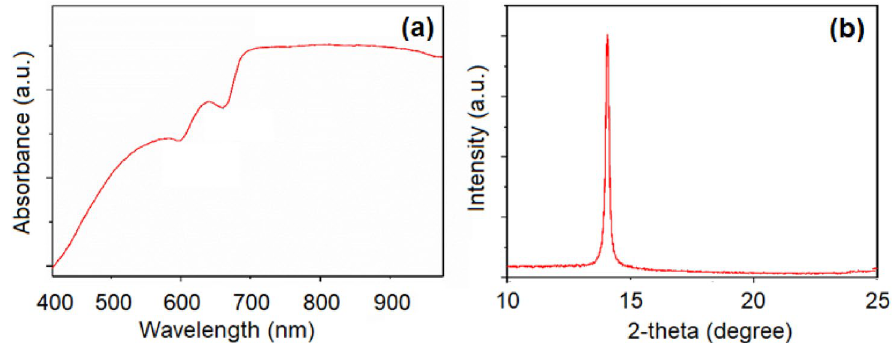
Figure 3. ( a ): Absorption spectrum of the synthesized MoS 2 nanosheets; ( b ) XRD pattern of MoS 2 nanosheets film on a silicon